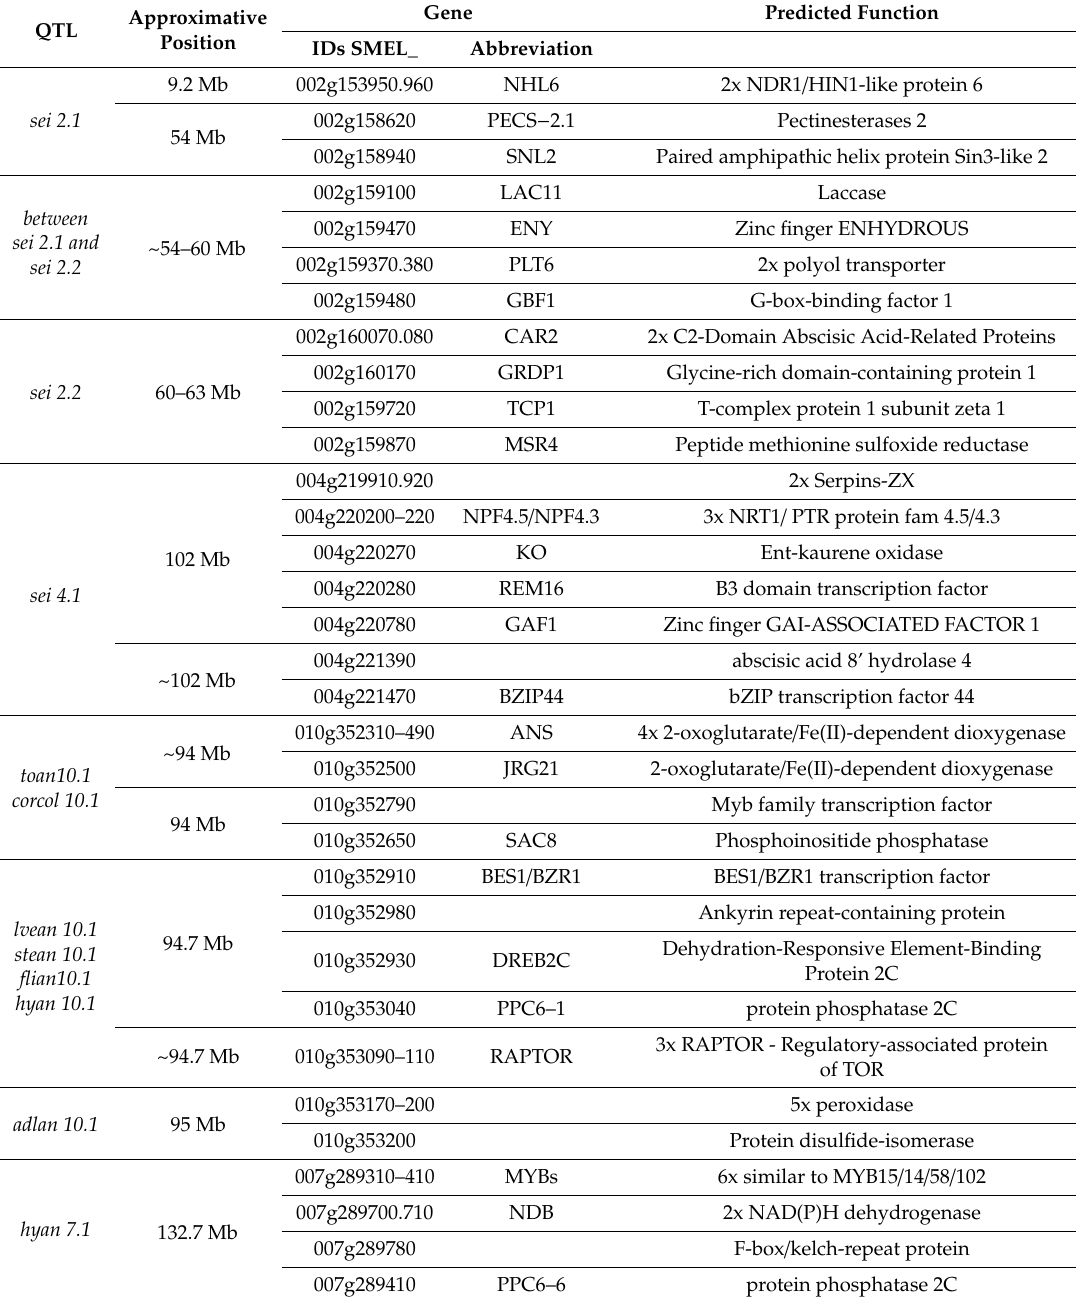
Table 5. Candidate genes spotted within the interval of detected QTLs. For each QTL, position, best candidate genes ID, acronym (abbreviation) and putative function are